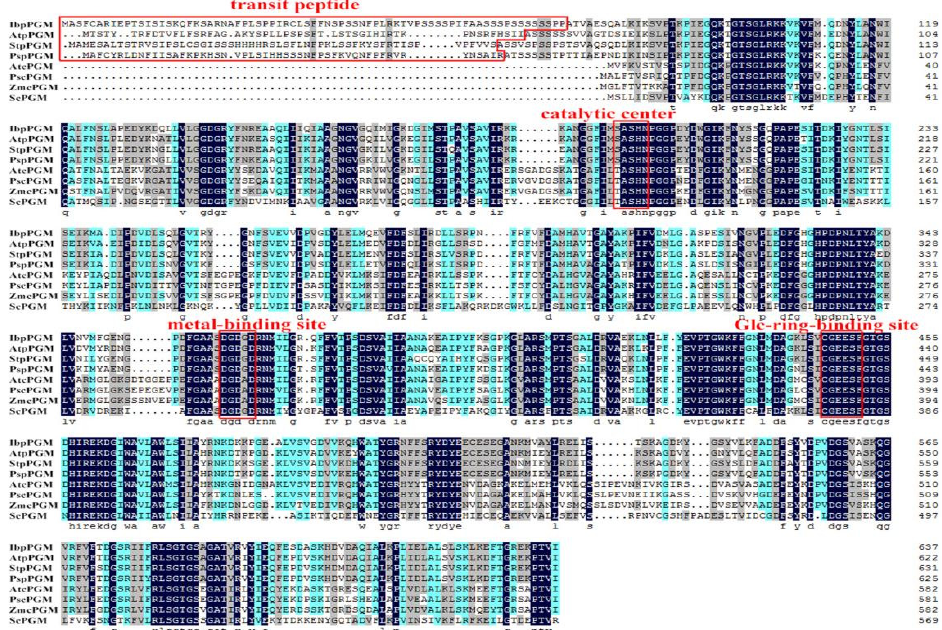
Figure 1. Multiple sequence alignment of PGM proteins. AtpPGM: Arabidopsis thaliana , AF216580; StpPGM: Solanum tuberosum , NM_001288352; PspPGM: Pisum sativum , AJ250770; AtcPGM: A. thaliana , At1g23190; PscPGM: P. sativum , AJ250769; ZmcPGM: Zea mays , U89341; ScPGM: Saccharomyces cerevisiae , NP_012795. Homology in amino acids is shaded with dark blue (homology = 100%), lightblue (homology ≥ 75%) or grey (homology ≥ 50%).